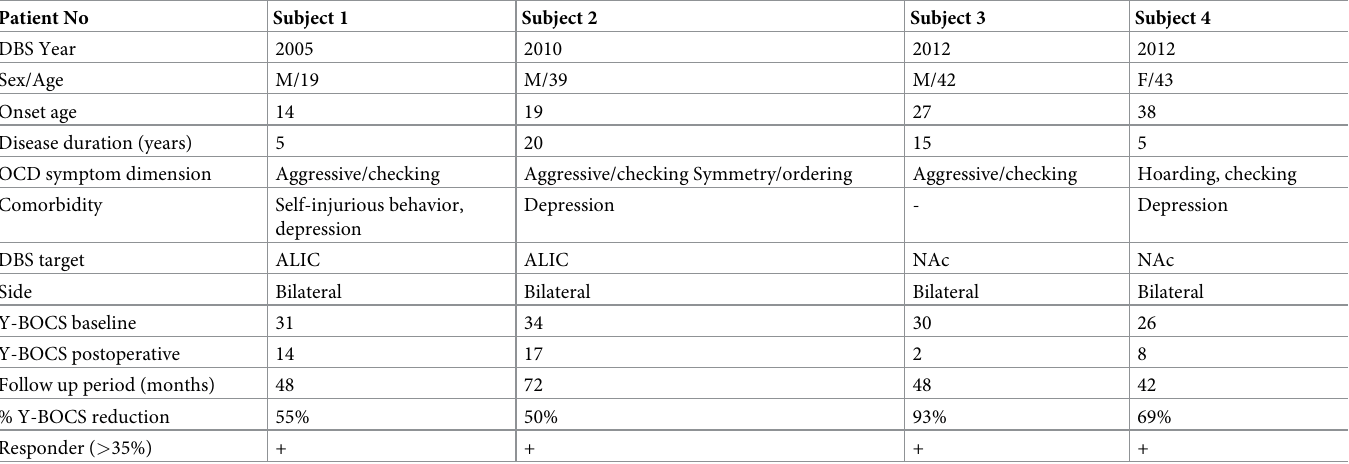
Table 1. Characteristics of all patient and treatment responses to